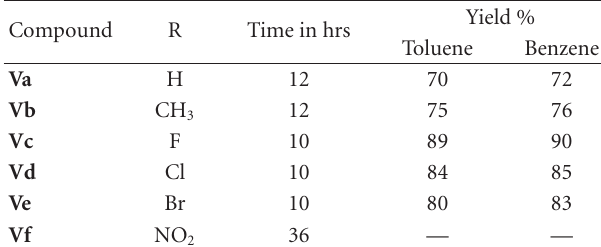
Table 2: E ff ect of solvent on 10 mol% ZnO NPs mediated amination of isocoumarins.